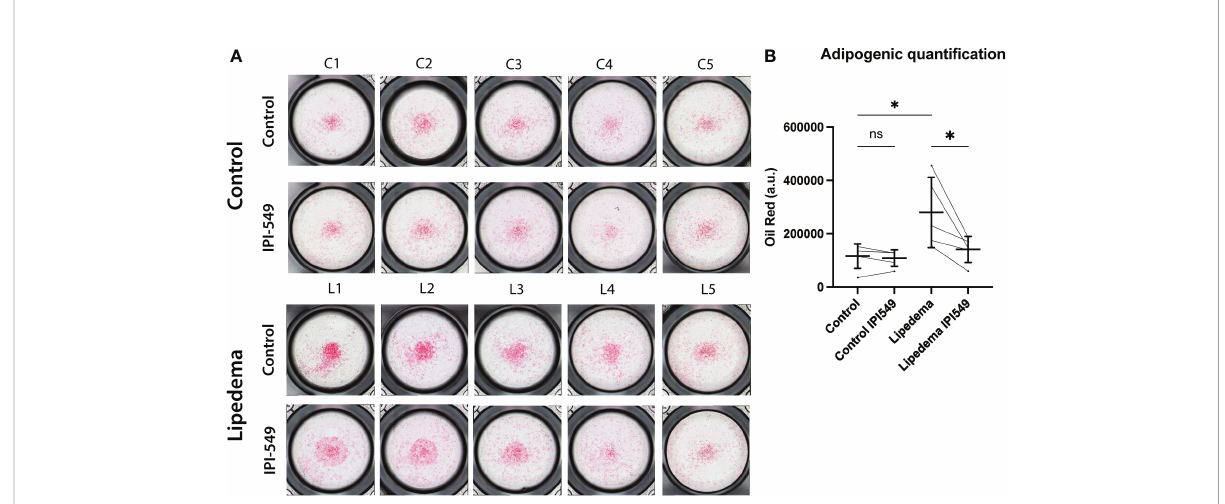
FIGURE 6 Conditioned medium from IPI-549 treated SVF normalizes adipose-derived stem cell differentiation in lipedema. (A) Representative pictures of Oil Red O stained ADSCs which were differentiated with condition medium from IPI-549 treated and untreated SVF of lipedema and control patients. (B) Quanti fi cation of the Oil Red staining. For the comparison between the treated and untreated sample of the same patient a paired T-test was used, for the comparison of the untreated lipedema to untreated control an unpaired T-test was used, N(C): 5, N(L): 5, Asterisks indicate statistical signi fi cance in comparison to the control *P < 0.05. ns, not signi fi